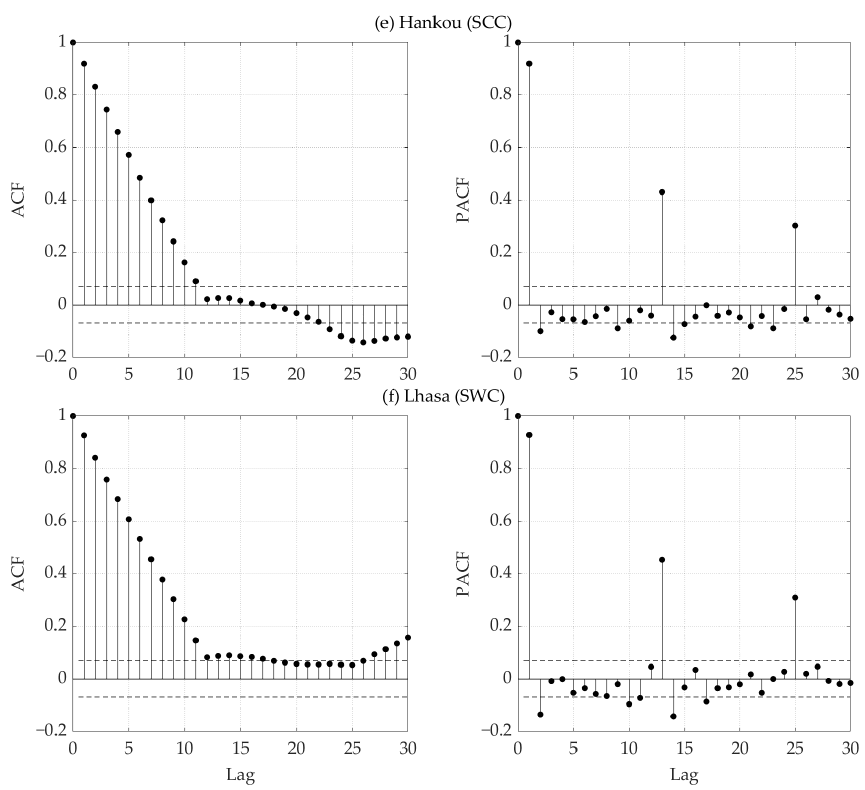
Figure A1. ACF and PACF plots of SPEI-12 at the stations: ( a ) Harbin (NEC), ( b ) Boketu (NC), ( c ) Maduo (NWC), ( d ) Guixi (EC), ( e ) Hankou (SCC), and ( f ) Lhasa (SWC). The ACF and PACF plots indicate that the time series are stationary.